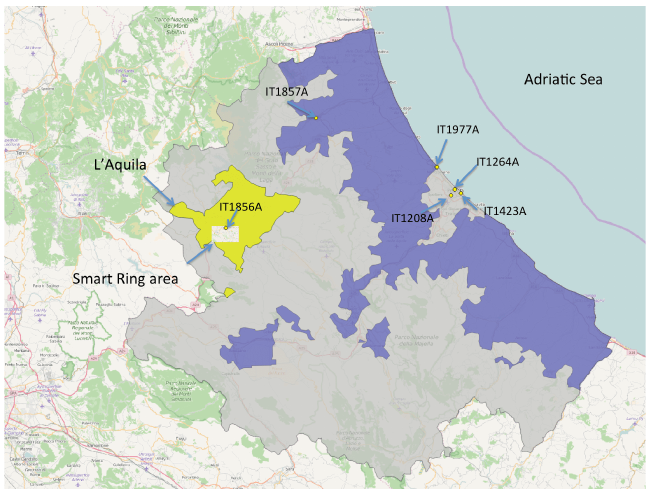
Figure 1. A view of the Abruzzo region where l’Aquila is located. The violet-blue areas indicate the air quality zone IT1306, which includes l’Aquila territory (in yellow). The points represent the reference fixed monitoring stations, as they are indicated in the European databases [35].